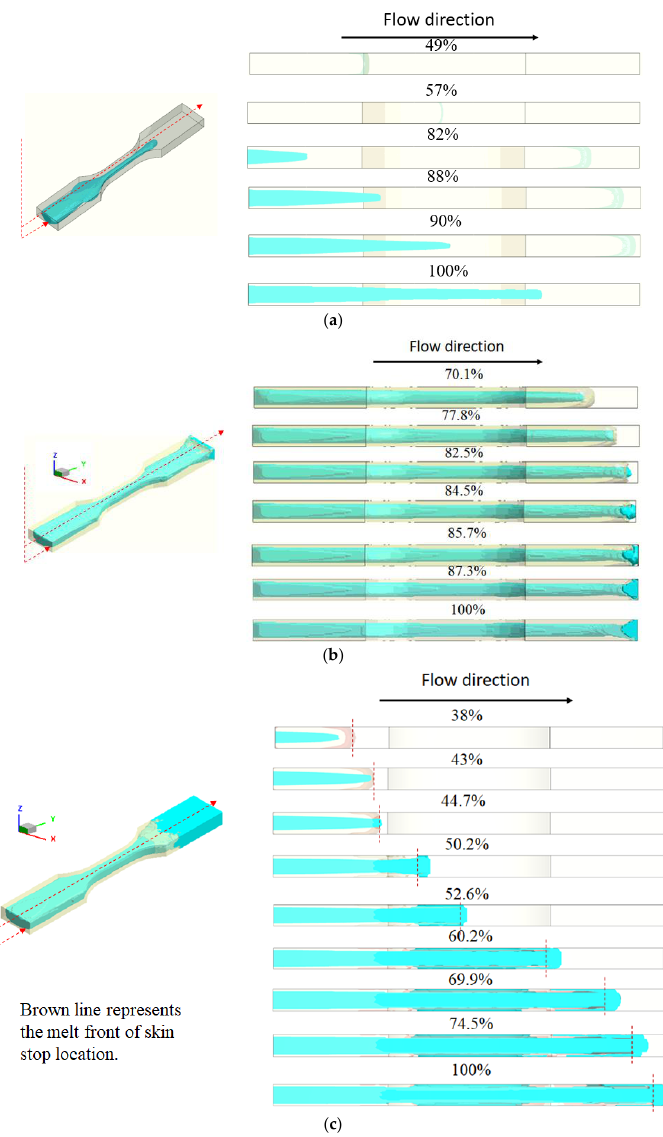
Figure 14. The dynamic behavior for core material advancement: ( a ) at skin to core = 70/30; ( b ) at skin to core = 50/50; and ( c ) at skin to core = 30/70.